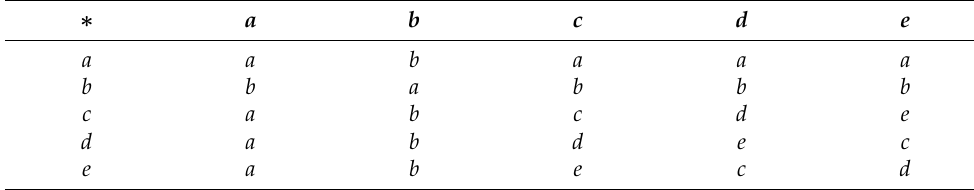
Table 9. A separative T2CA-groupoid of Example